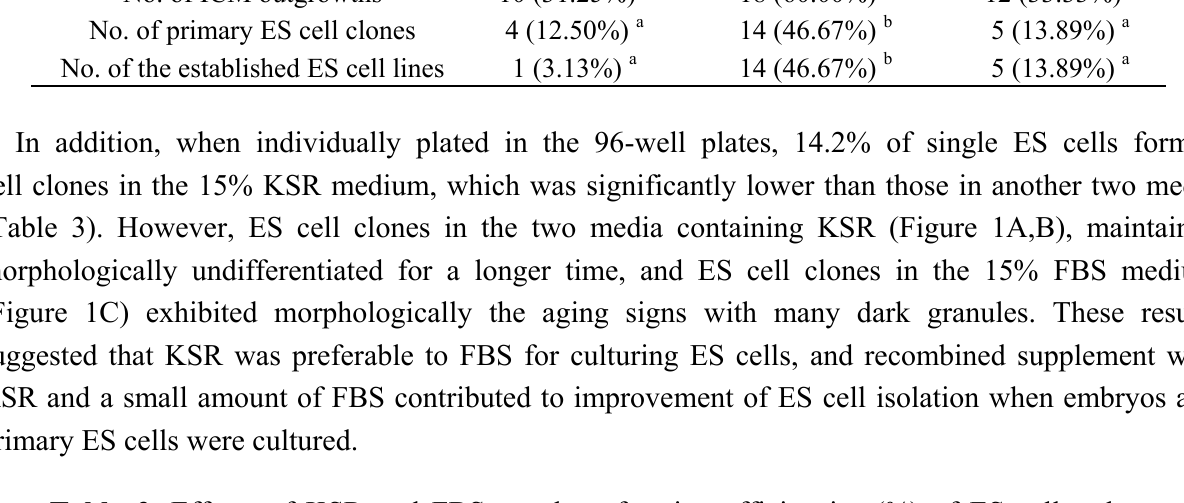
Table 3. Effects of KSR and FBS on clone-forming efficiencies (%) of ES cells when single-cells were